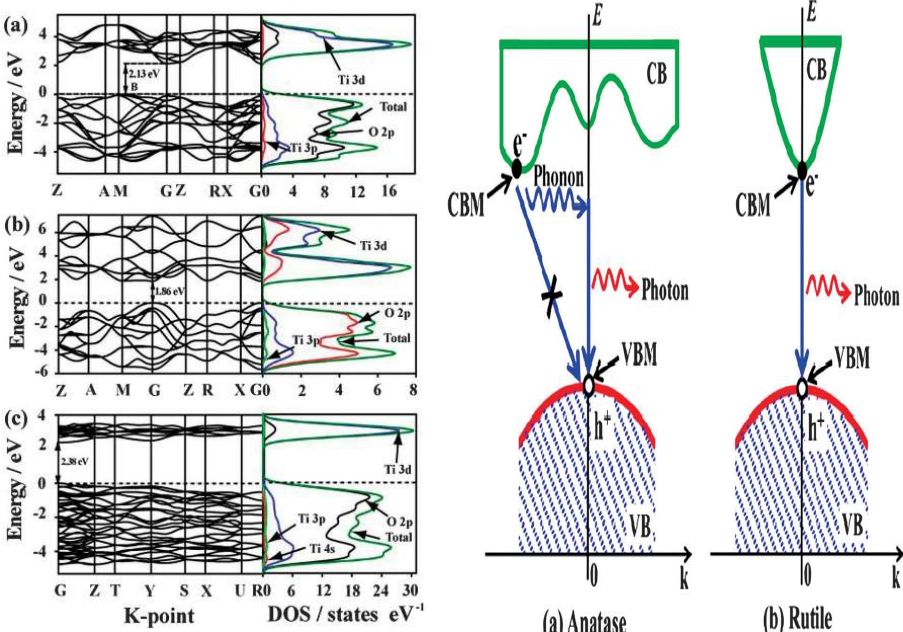
Figure 5. The band structure and DOS for ( a ) anatase, ( b ) rutile, and ( c ) brookite TiO 2 , and comparison of the recombination processes of photogenerated electrons and holes within ( a ) indirect-gap anatase and ( b ) direct-gap rutile. Adapted from reference [58].